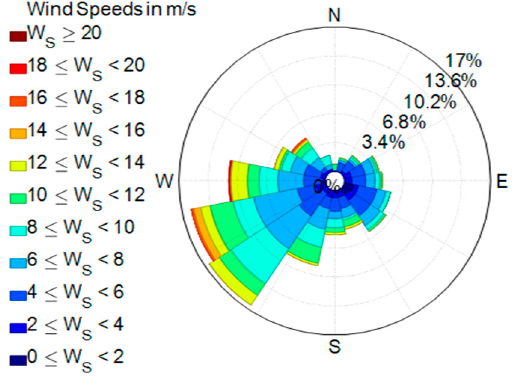
Figure 2. The wind rose for the full year (2016).